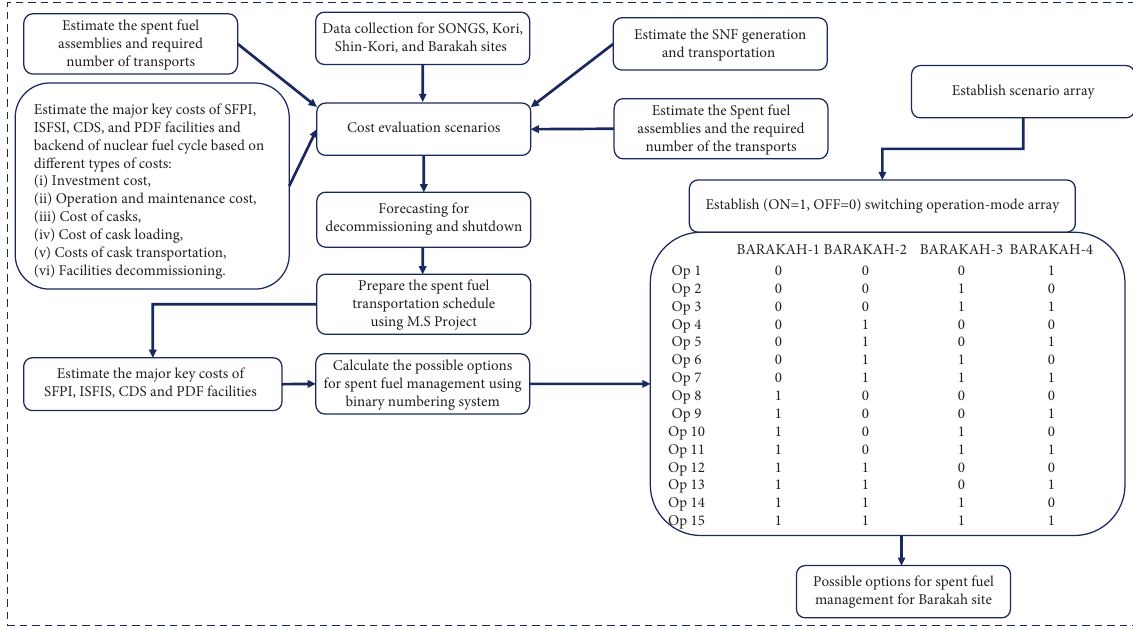
Figure 8: Overall procedure for spent fuel management for Barakah site. Table 14: Summary of total cost (M USD) per cost